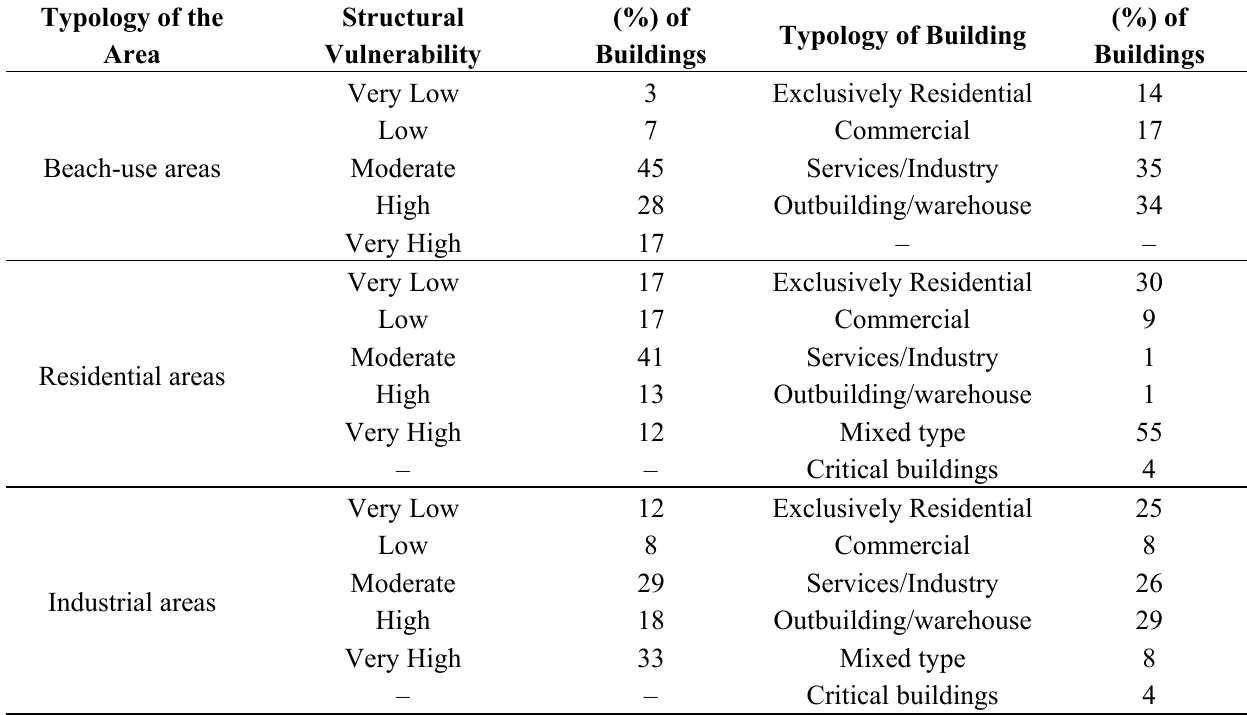
Table 8. Percentage of buildings by vulnerability classes and by